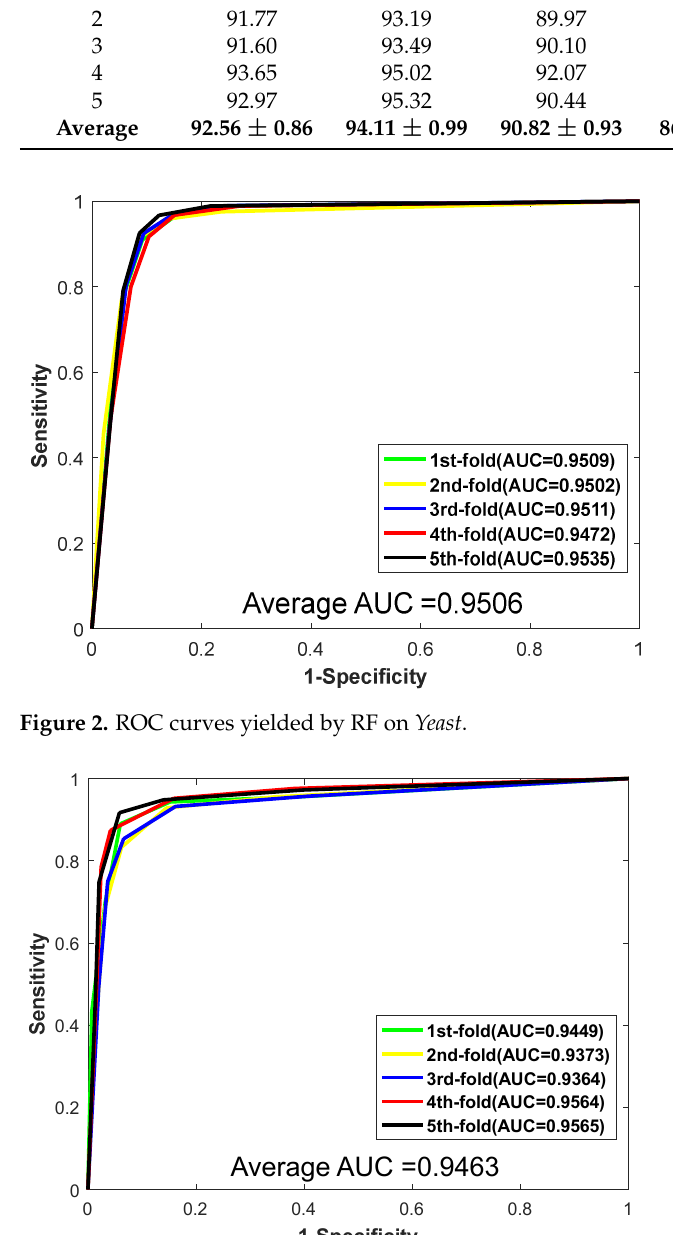
Table 3. Prediction performance of the H. pylori dataset based on five-fold cross-validation method. Testing Set